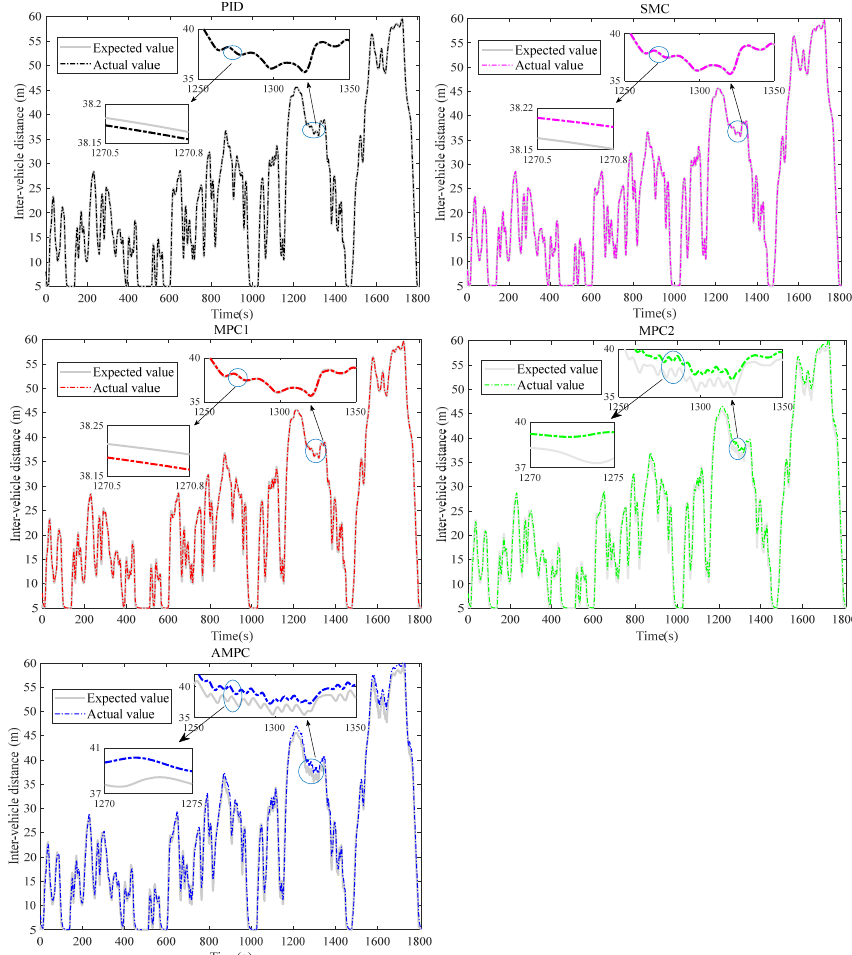
Figure 10. Distance tracking curve of each controller.